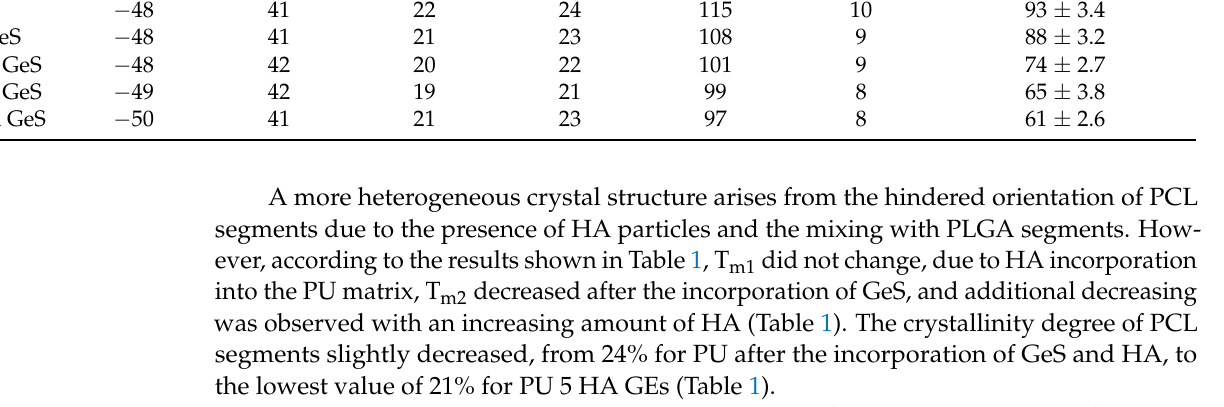
Table 1. Summary of DSC and water-contact-angle results.